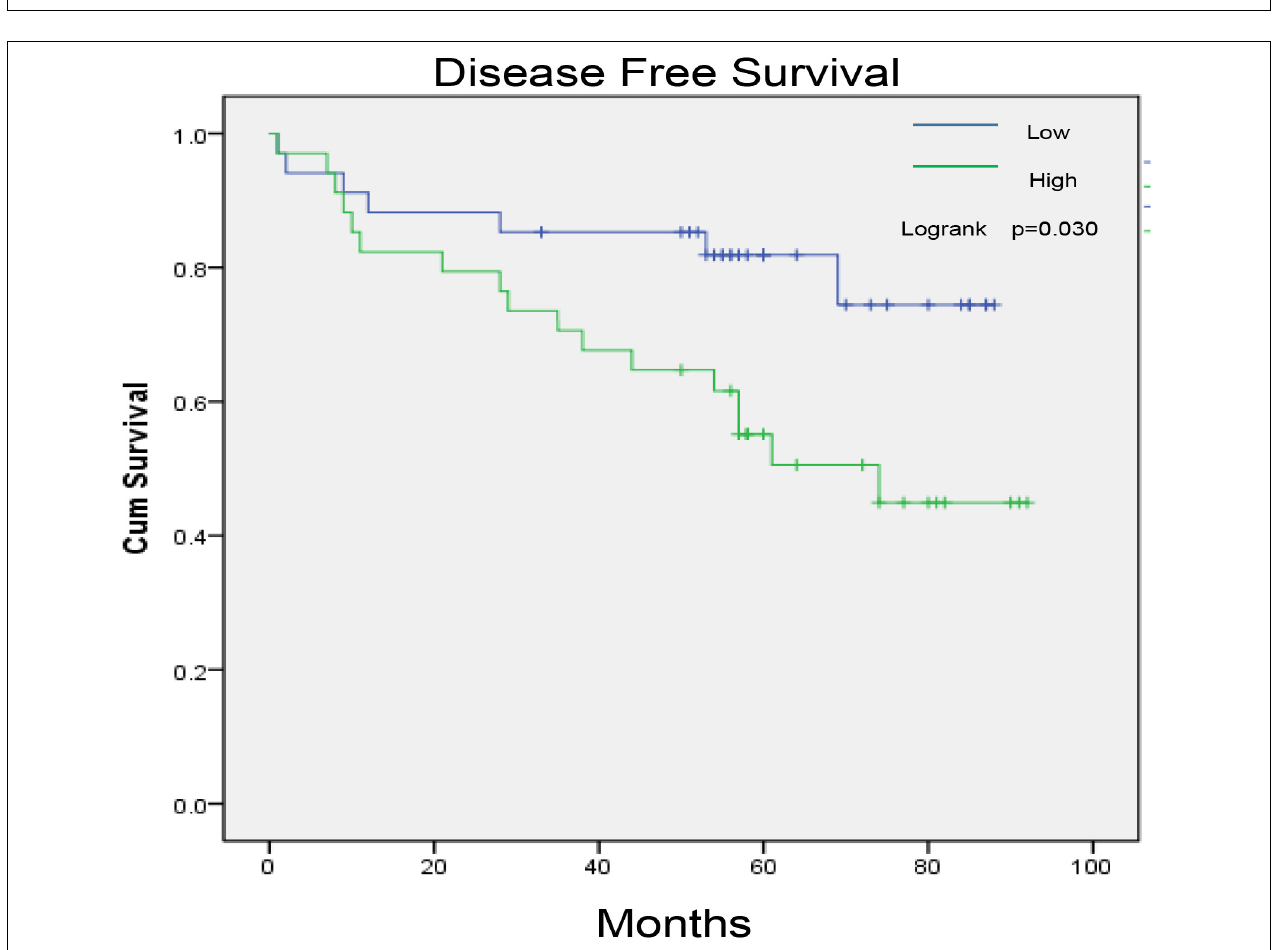
survival (PFS) of ccRCC patients than low expression ones ( p < 0.05). As Figure 2 showed, we further used the TPEF/SHG technique to determine the intratumor fibrosis of 68 patients with